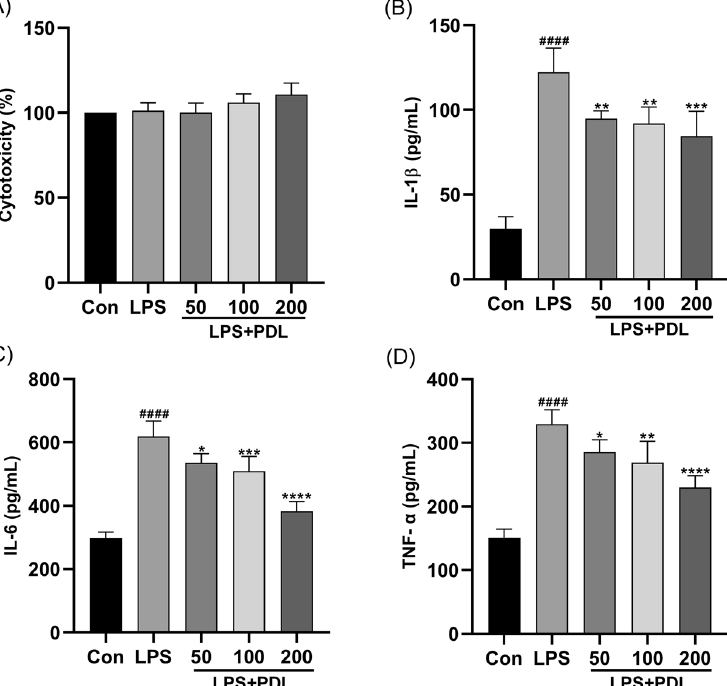
Figure 7. PDL inhibited the inflammatory response of LPS-induced RAW264.7 cells. Effect of PDL on ( A ) cytotoxicity, ( B ) IL-1β, ( C ) IL-6 and ( D ) TNF-α production in RAW264.7 macrophages activated with LPS. The values are expressed as the mean standard deviation (n = 3). #### p < 0.0001 vs vehicle control cells. *p <